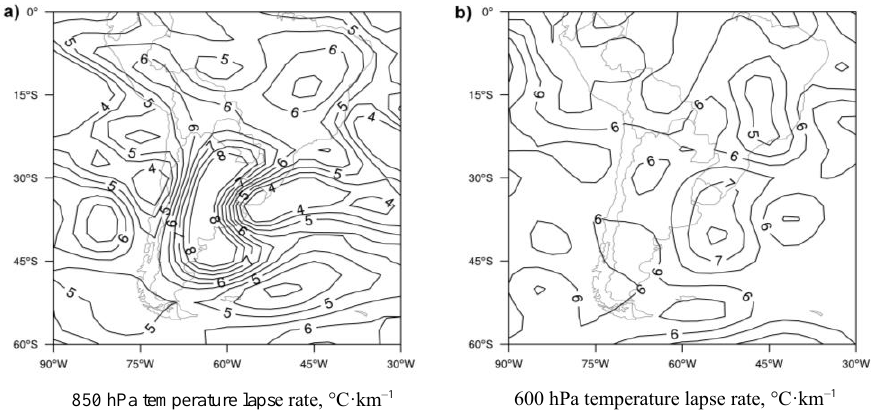
Fig. 6. Average thermal gradient for 8 January 2012 at: a) 850 hPa; b) 600 hPa. Figure built from images provided by the Earth System Research Laboratory of the National Oceanic and Atmospheric Administration, Boulder, Colorado, on its website